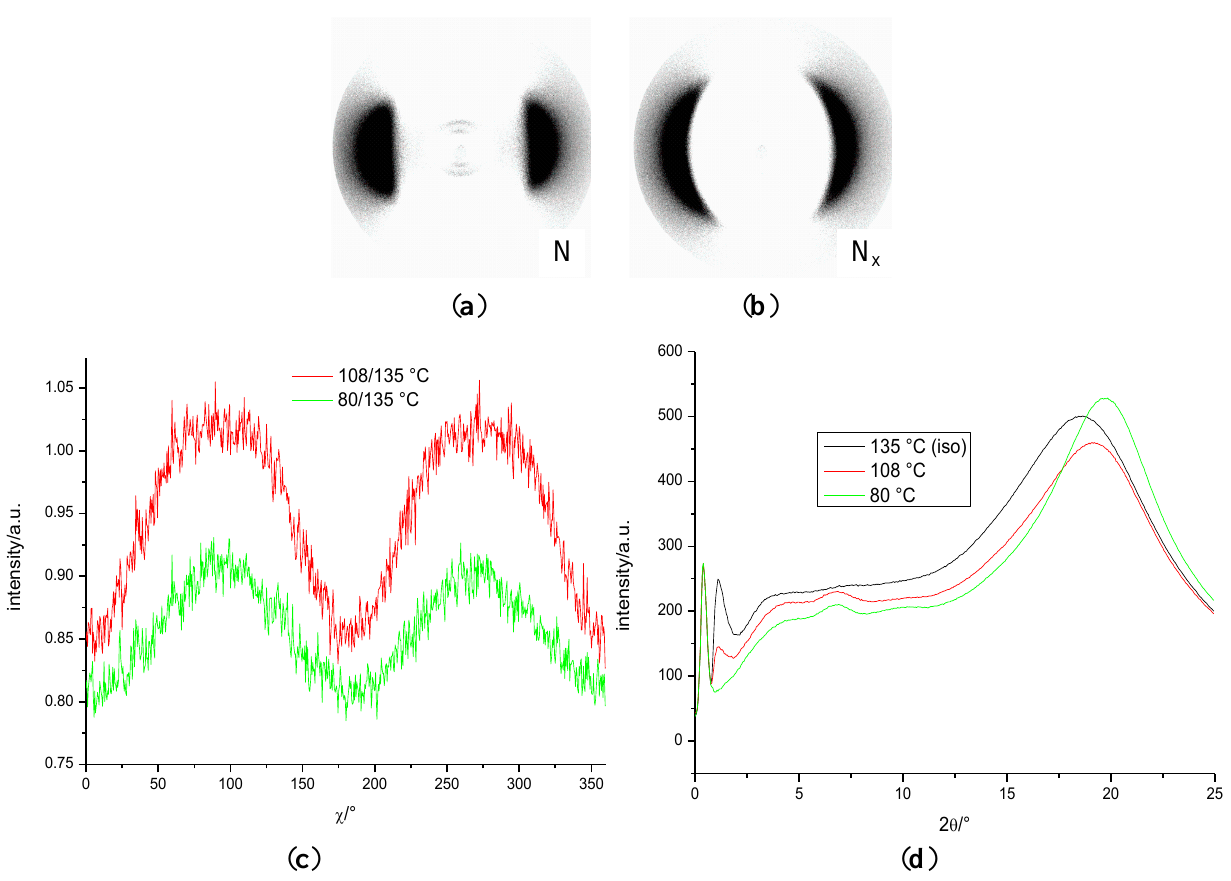
Figure 18. XRD patterns of an aligned sample of the mixtures, MGTP211 , in a magnetic field (vertical) on cooling: ( a ) N phase at 108 °C; ( b ) N wide-angle scattering along χ in the N and N ( d ) θ-scan of the diffraction pattern in the N and N d = 1.29 nm (80